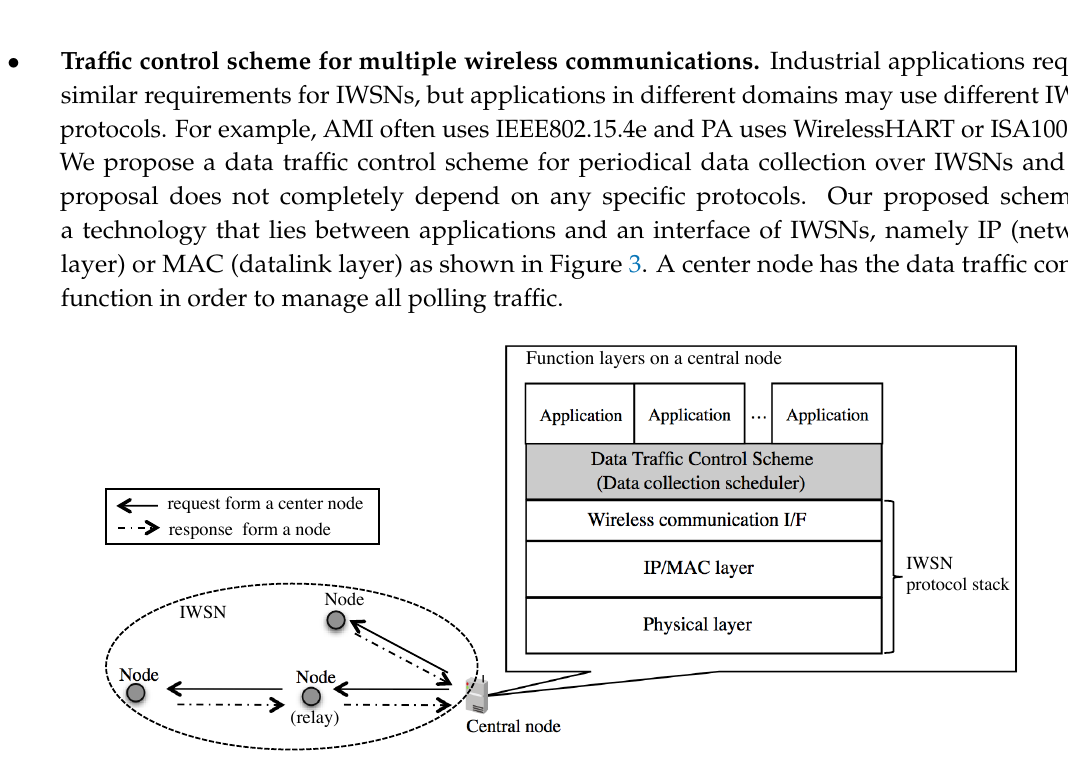
Figure 3. Position of our data traffic control scheme in function